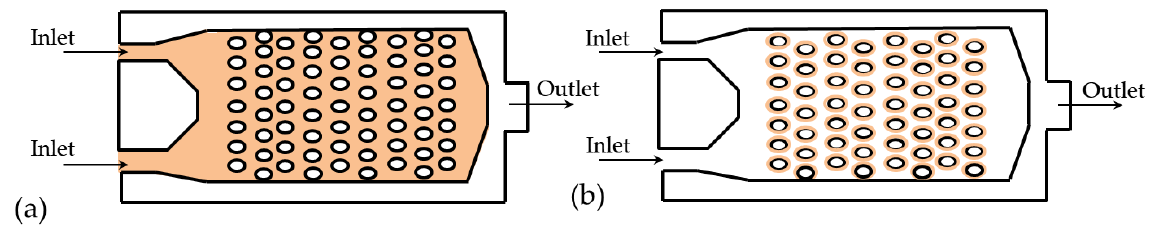
Figure 6. Distribution of biofilm in a microbioreactor: ( a ) suspended biofilm and ( b ) immobilized biofilm. Inspired by [116].